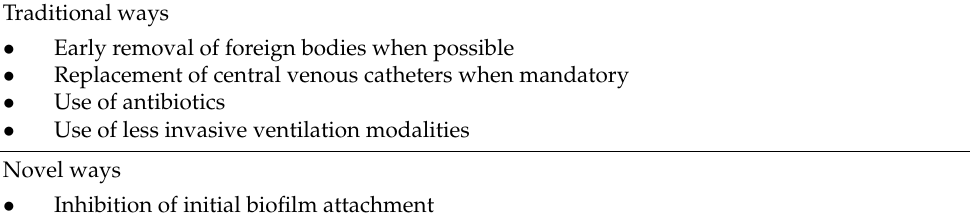
Table 4. Traditional and novel ways of fighting biofilm